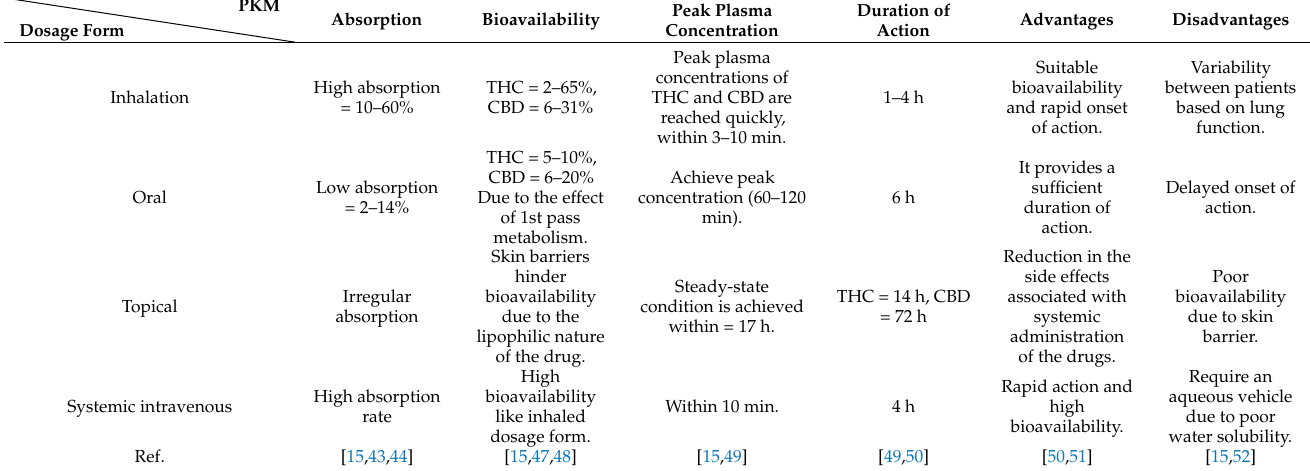
Table 1. Effect of various dosage forms on pharmacokinetics parameters (PKM) of